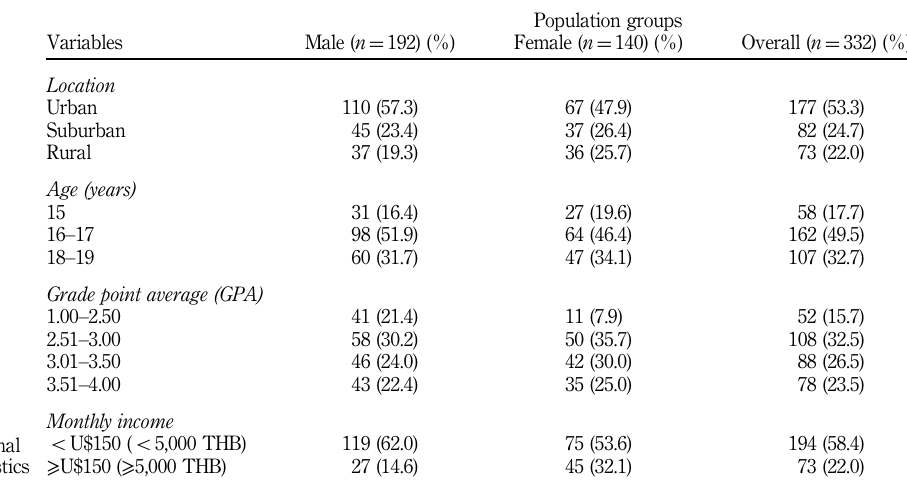
Table I. Frequency and percentage of adolescent vocational student